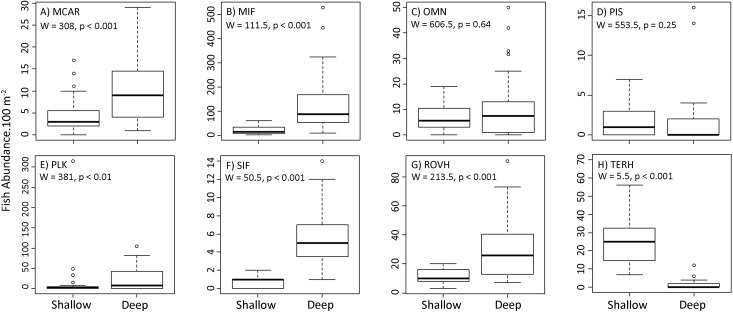
Trophic groups when comparing reef fish assemblages in shallow and deep reefs in northeastern Brazil.Macrocarnivore (MCAR); Mobile invertebrate feeders (MIF); Omnivores (OMN); Piscivores (PIS); Planktivores (PLK); Sessile Invertebrates Feeders (SIF); Roving Herbivores (ROVH) and Territorialist Herbivores (TERH).